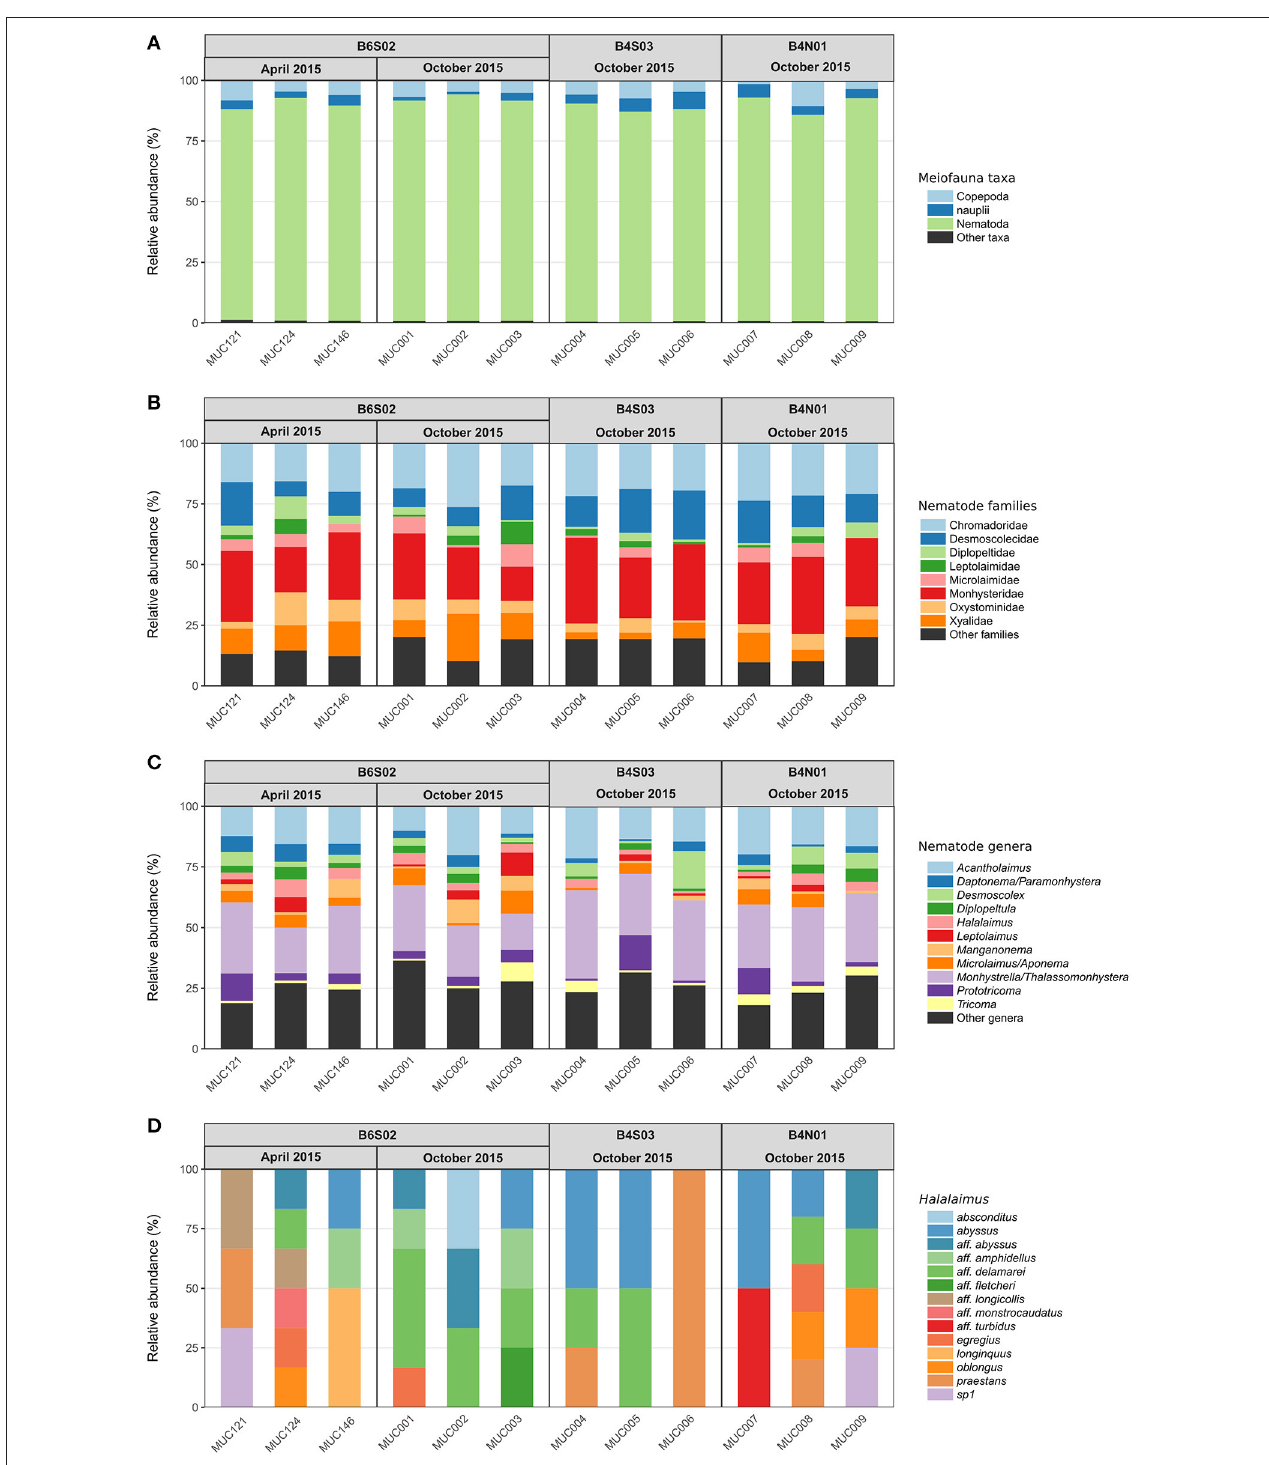
FIGURE 4 | Relative abundances of (A) higher meiofauna taxa, (B) nematode families, (C) nematode genera, and (D) Halalaimus species per multicorer (MUC) sample for all sites sampled in the GSR license area during GSRNOD15A (October 2015, all sites) and SO239 (April 2015, site B6S02). “Other taxa” are higher meiofauna taxa that contributed < 1% to total meiofauna abundance. “Other families” comprised < 1% of the total number of nematodes identified per sample, and “other genera” comprised < 5% of the total number of nematodes identified per sample.